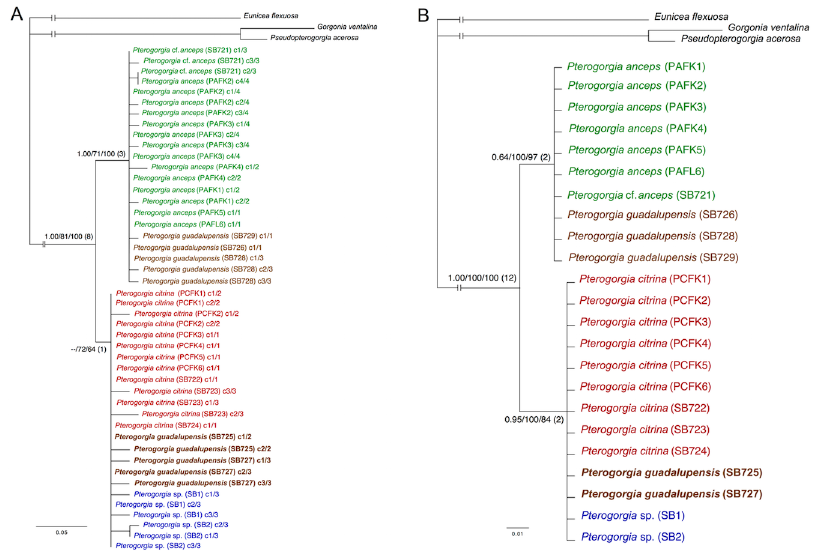
Fig 5. SRP54 phylogenies. Phylograms generated from SRP54 sequences for (a) unique clones found for each individual and (b) consensus sequences for each individual using Bayesian Inference (BI), maximum likelihood (ML), and maximum parsimony (MP). Node support for BI, ML and MP is shown from left to right, with Bremer decay values in parentheses. A method with node support < 50 contains “— ". In (a) clones are coded by a “ c ” (clone) followed by the number of the clone relative to the total unique clones found for that individual, and arranged by taxonomic affinity for clarity. Taxa in bold are individuals whose placement differed between the SRP54 (nuclear) and mitochondrial phylogenies (see Fig